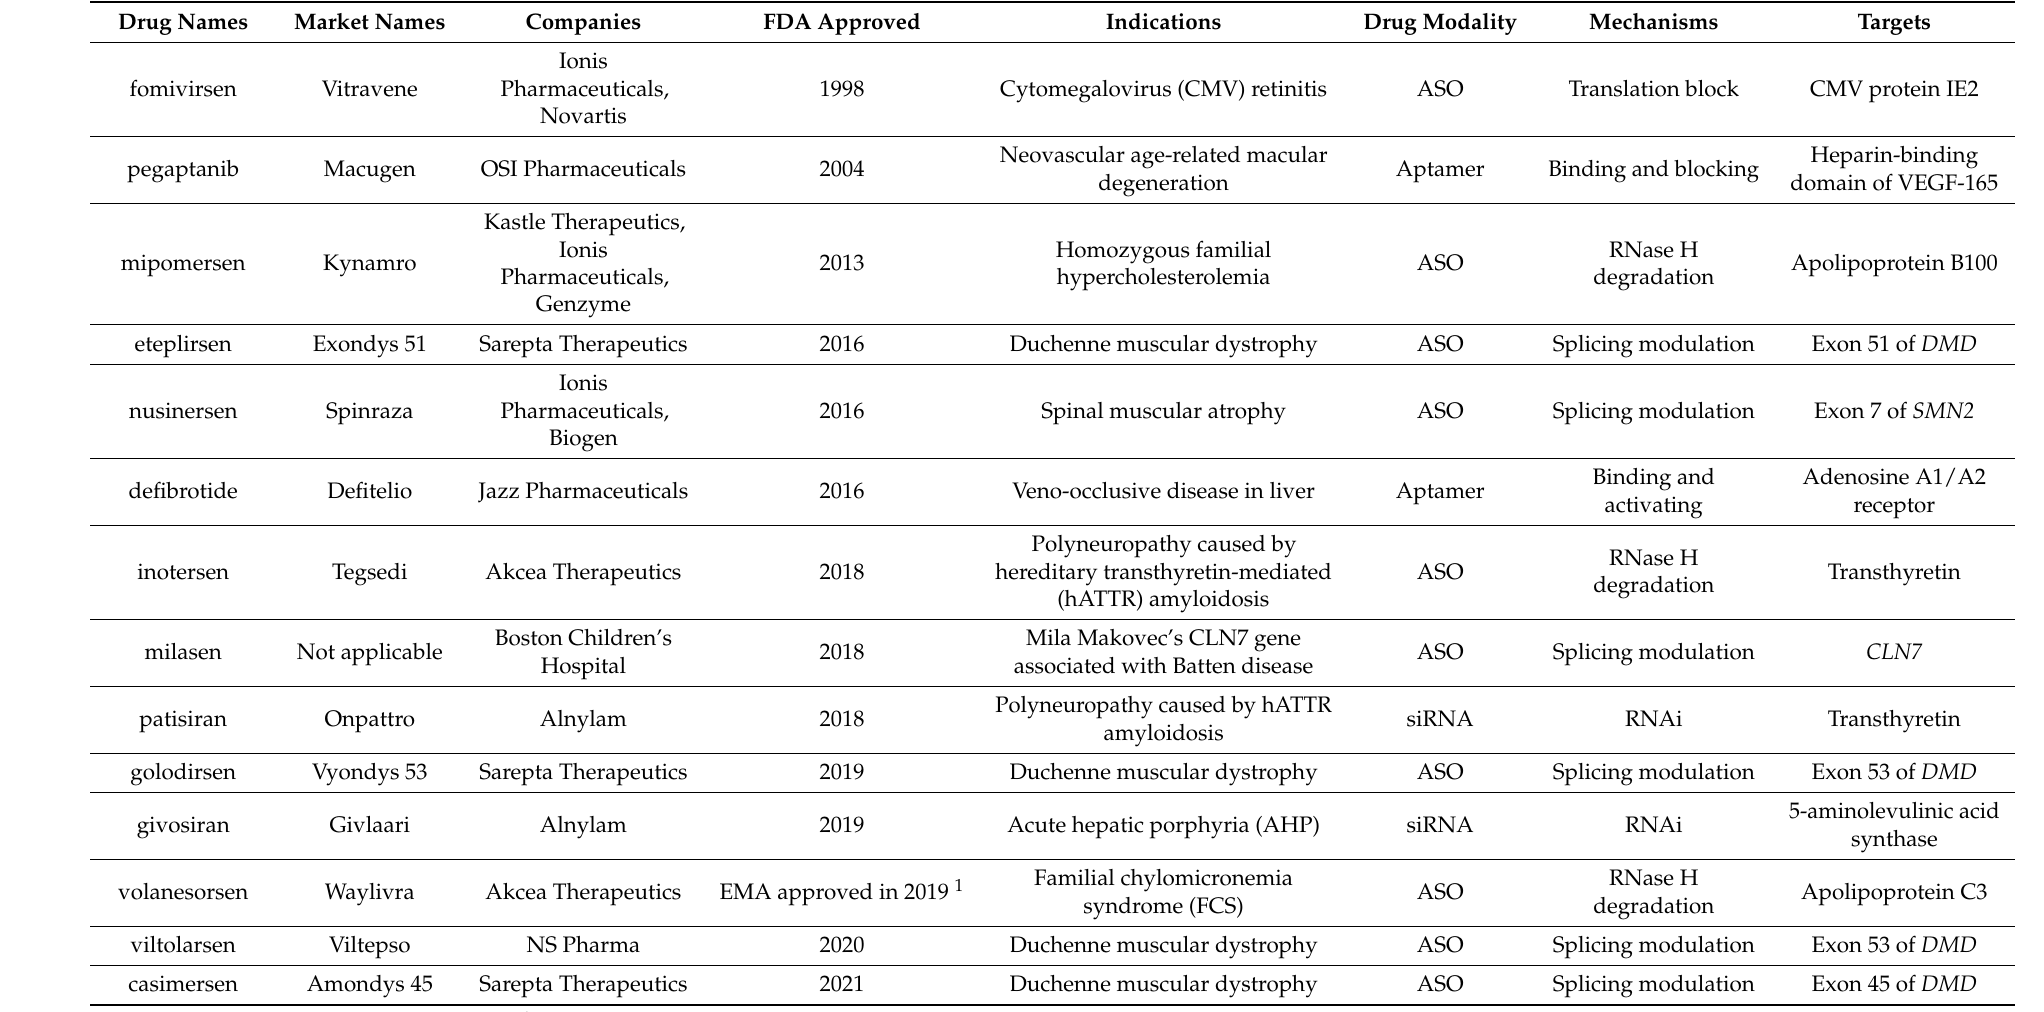
Table 1. Summary of currently approved oligonucleotide